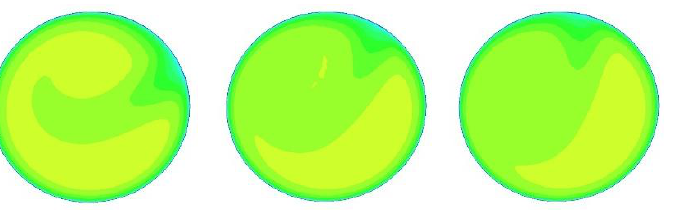
Figure 6. Velocity cloud diagrams at 2, 4, and 6 m/s at x = 300 cm (from left to right).